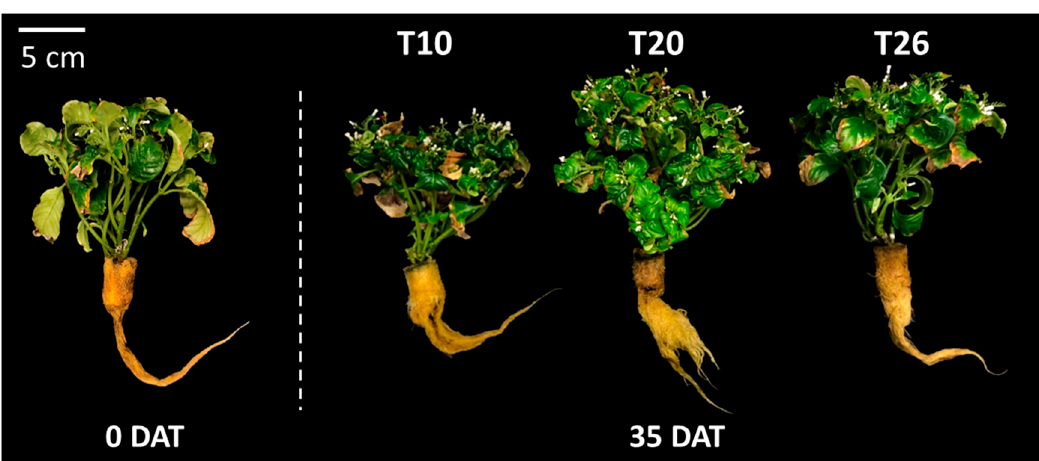
Table 4. Effects of nutrient solution temperature (NST) on camptothecin concentrations in O. pumila at 35 days after the start of the treatment (DAT) in experiment 2.